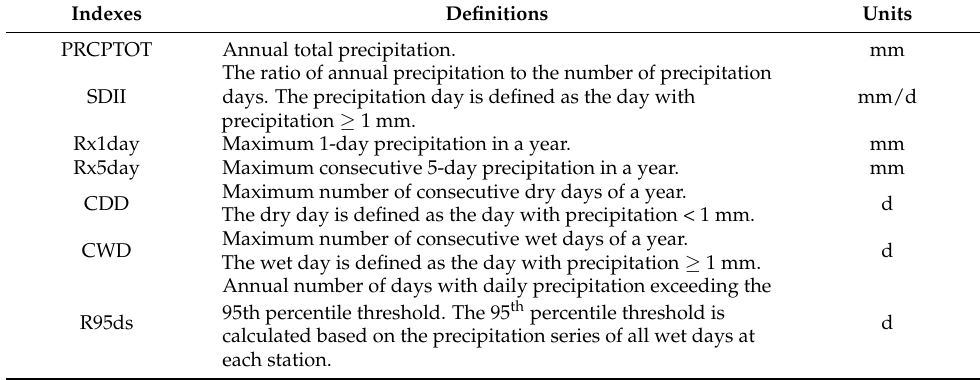
Table 1. Information for seven precipitation indexes defined by